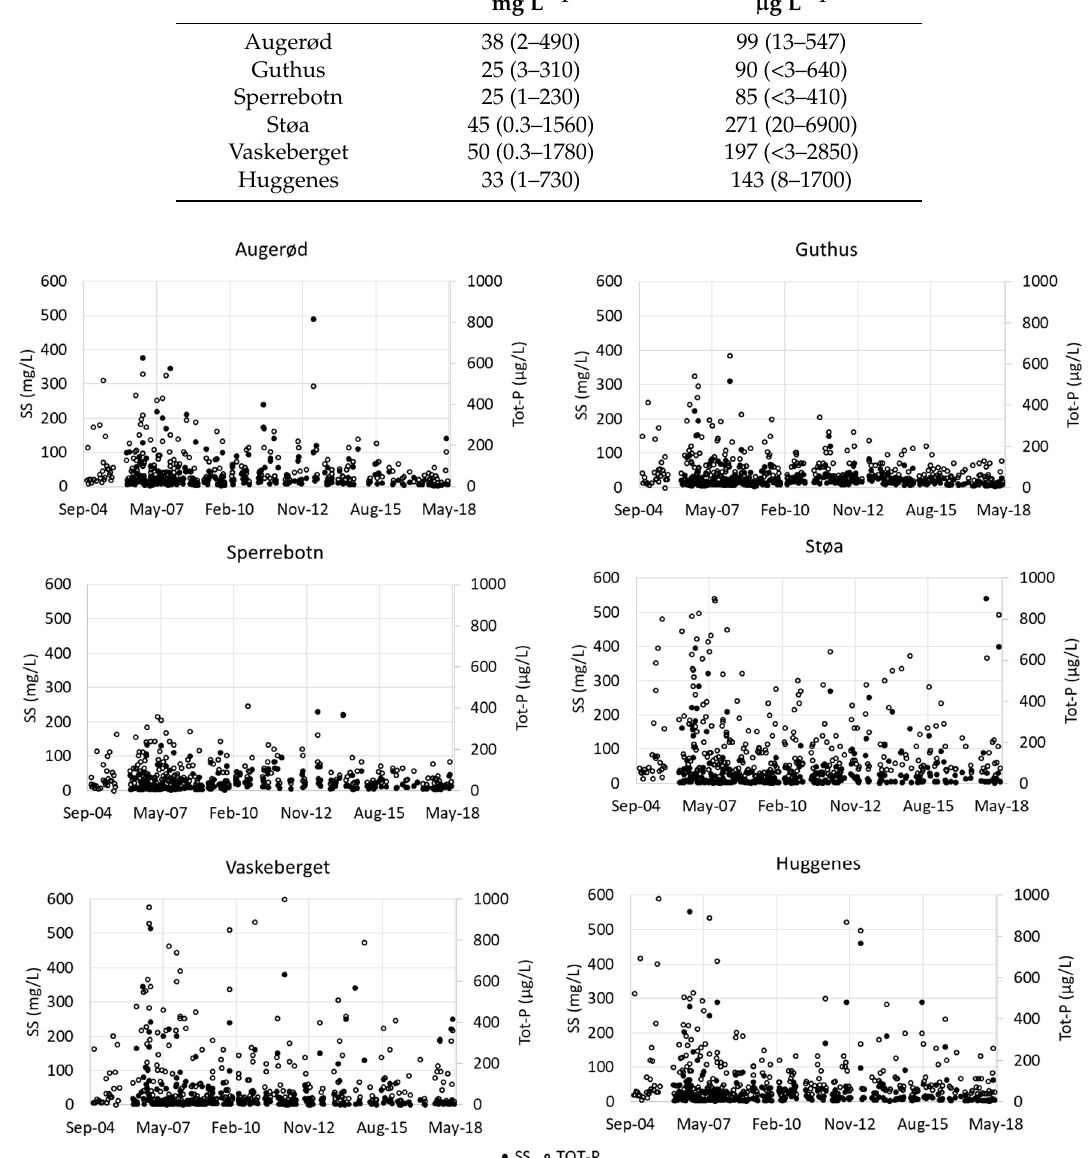
Figure 4. Concentrations of suspended sediments (mg L − 1 ) and total phosphorus (ug L − 1 ) in water samples taken from the six streams during the monitoring period. All samples for Augerød, Guthus, and Sperrebotn and samples below 600 mg SS L − 1 and 1000 µg TP L − 1 for Støa, Vaskeberget, and Huggenes.